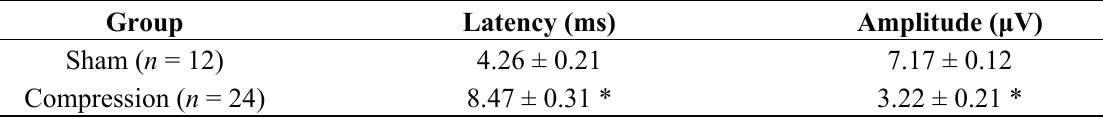
Table 2. Average amplitude and latency of the two groups (* p <